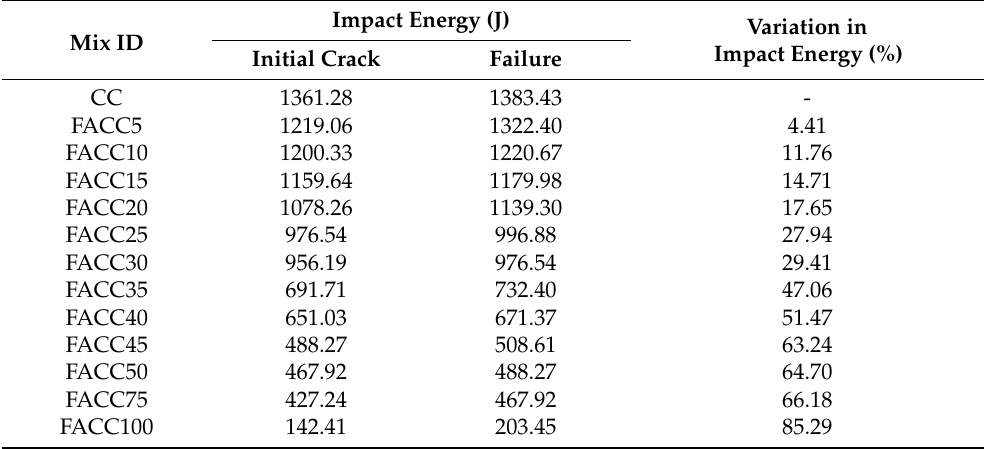
Table 7. Variation in Impact Energy of FACC Mixes with